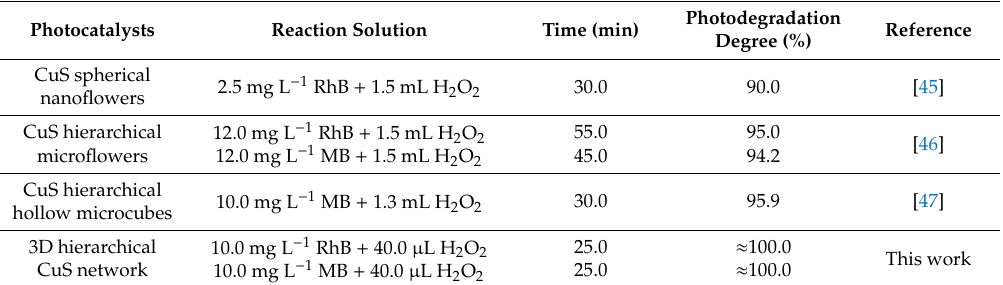
Table 1. Photocatalytic activity data of different CuS catalysts for the degradation of different organic dyes.